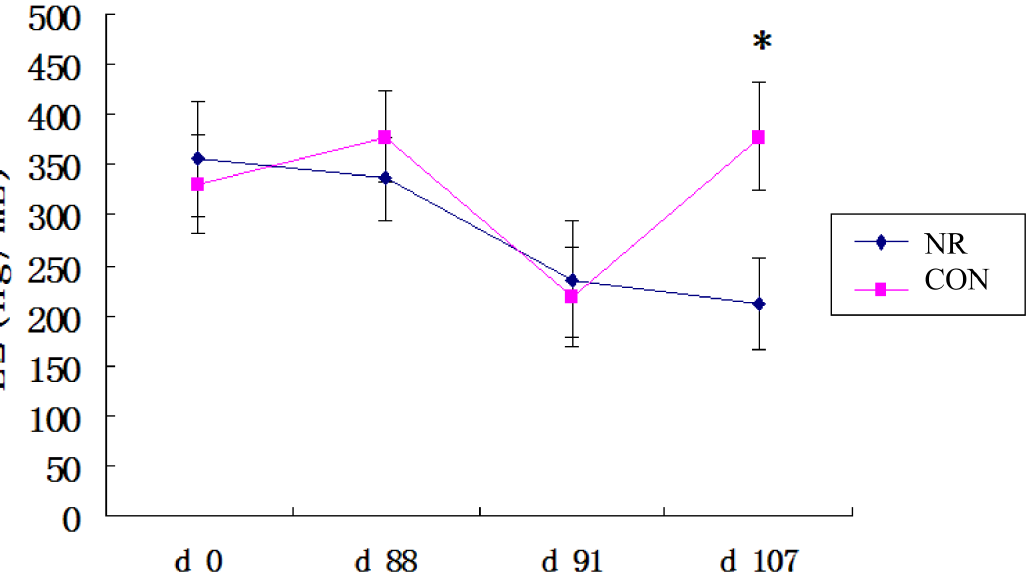
Fig 2. Concentrations of estradiol (E2) in normal (CON) or nutrient-restricted (NR) gilts. CON denotes normally fed gilts (2.86 kg/d) and NR denotes nutrient restricted gilts (1 kg/d). The day of the second occurrence of standing heat was designated as d 0. P, progesterone; E2, estradiol. * denotes P < 0.05. n = 10.